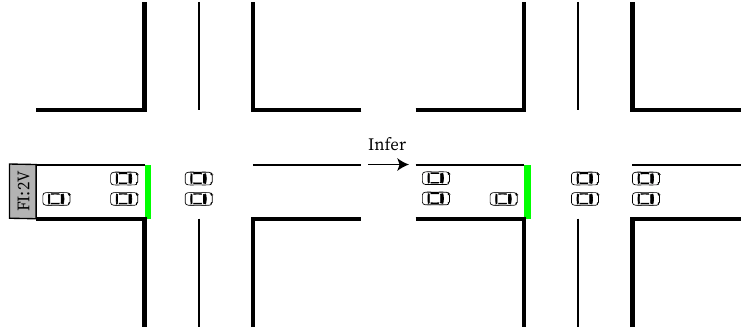
Figure 1. Traffic inference with future information. The green line means the light is green for the